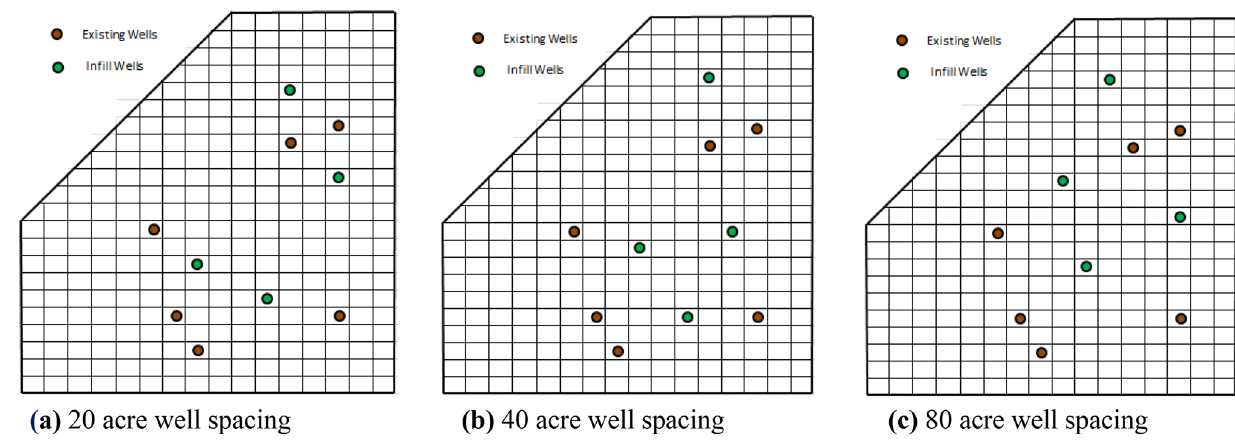
Fig. 15 Optimized locations for 4 vertical infill wells at different well spacings. Existing wells are indicated by brown color and infill wells rep- resented by green